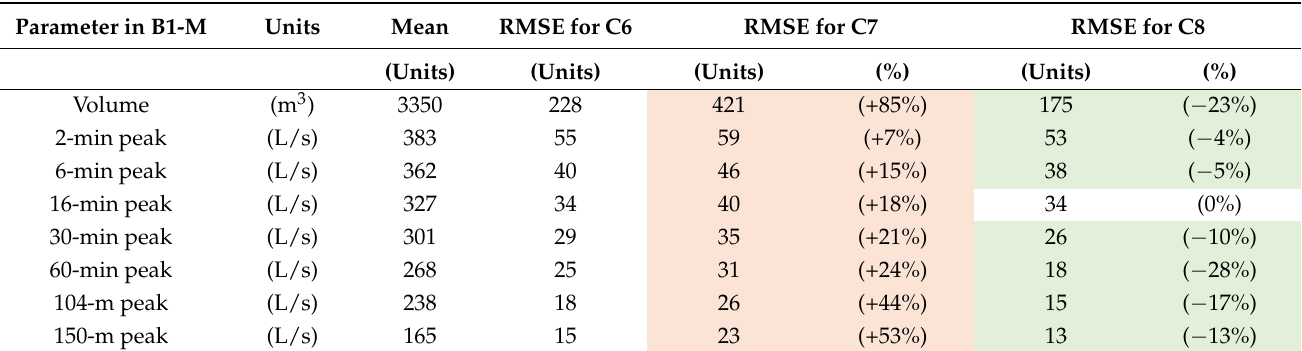
Table 6. RMSE values in B1-M for assessment C6 and relative variations of RMSE for both assessment C7 and assessment